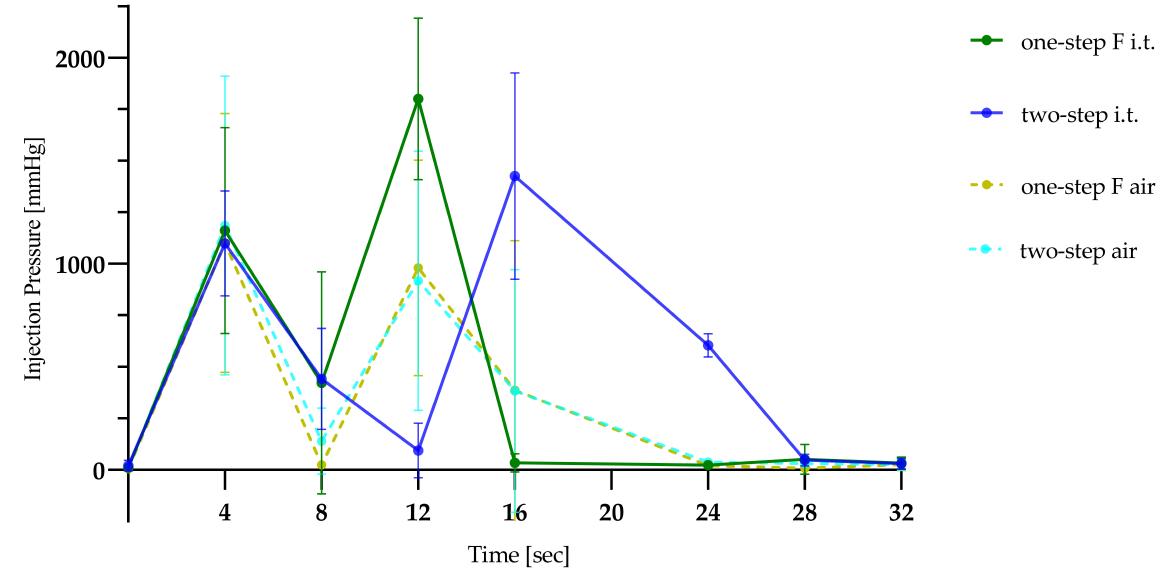
Figure 3. Injection pressure profiles of the two injection methods into the testis and air. i.t. = intratesticular.